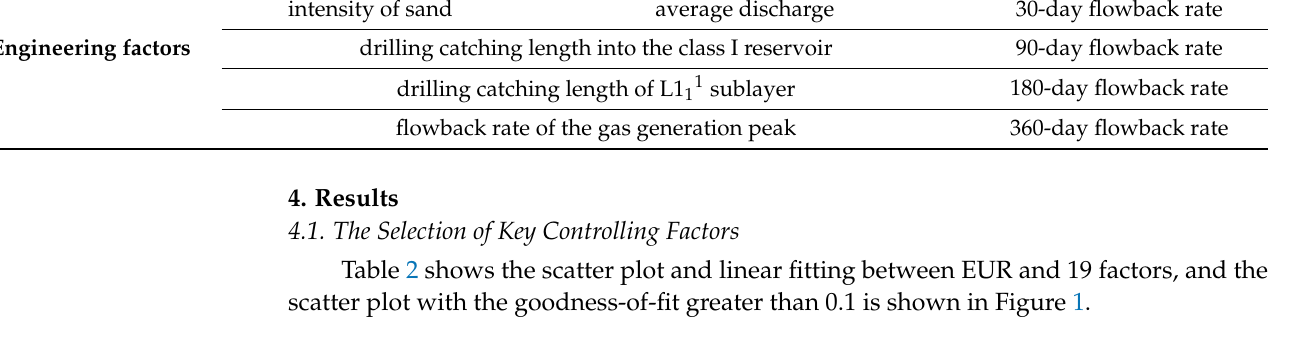
Table 2. The linear fitting between estimated ultimate recovers (EUR) and various factors (R 2